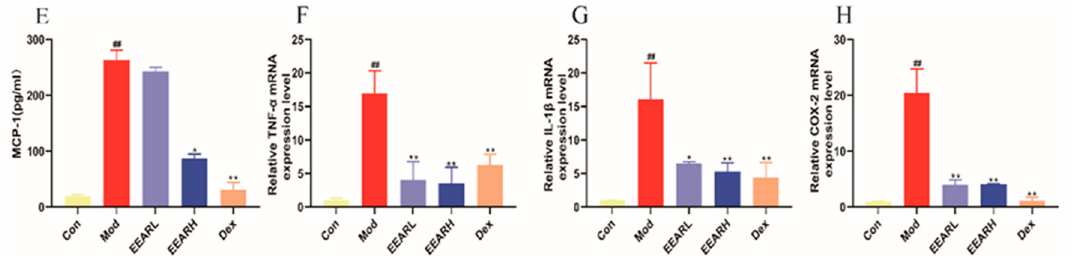
Figure 7. EEAR inhibited the expression of LPS-induced inflammatory factors in THP-1 cells. ( A ) Cell viability after EEAR exposure measured using a CCK-8 assay ( n = 5). ( B ) Expression of TNF- α in cell supernatants ( n = 3). ( C ) Expression of IL-1 β in cell supernatants ( n = 3). ( D ) Expression of IL-6 in cell supernatants ( n = 3). ( E ) Expression of MCP-1 in cell supernatants ( n = 3). Relative expression of ( F ) TNF- α , ( G ) IL-1 β , and ( H ) COX-2 in LPS-stimulated THP-1 cells evaluated by RT-qPCR ( n = 3). Values are expressed as means ± SEM. ### p < 0.001 vs. Control; ## p < 0.01 vs. Control; ** p < 0.01 vs. Model; * p < 0.05 vs. Model.